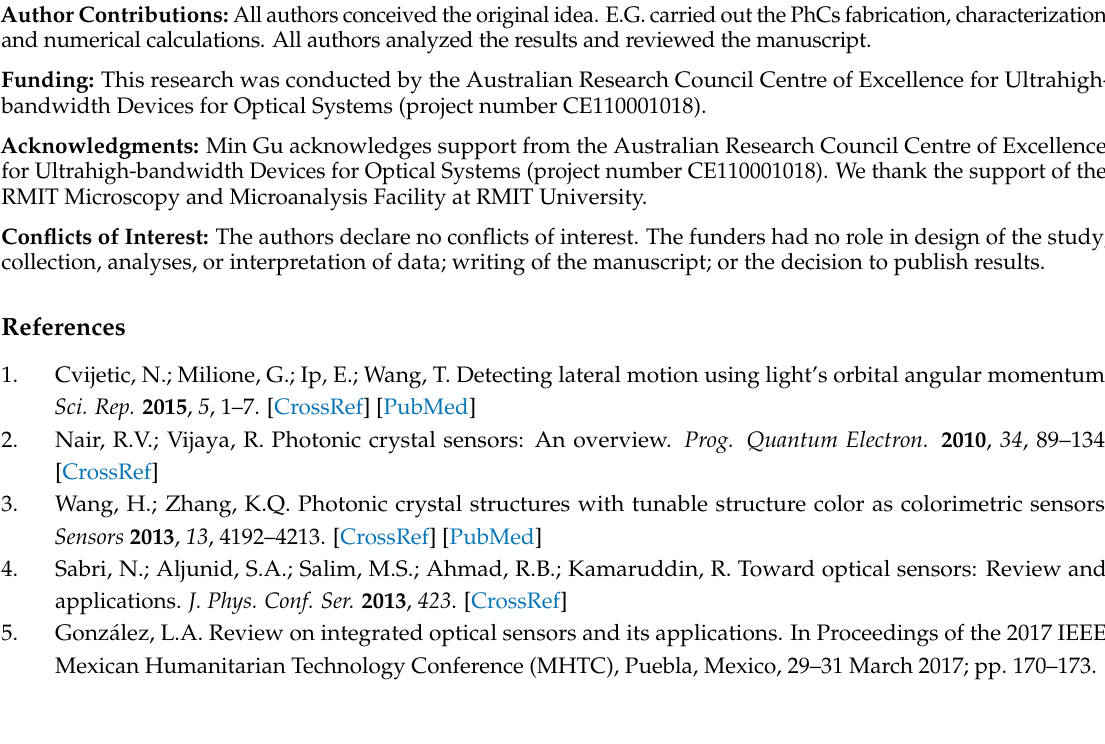
Figure S1: Axial and lateral linewidths obtained from SEM images taken along the [011] direction. (a) In this configuration the sample is tilted by an angle of 45 ◦ , therefore the lateral dimension ∆ X can directly be extracted by the images. To obtain the real ∆ Z value, it is necessary to multiply the measured value by of 2-srs PhC fabricated using DLW and corresponding values of ∆ X, ∆ Z and e . (c) SEM image of 2-srs PhC fabricated using GD-DLW and corresponding values of ∆ X, ∆ Z and e . The software used for the measurements is ImageJ; Figure S2: SEM image of 8-srs PhCs fabricated using GD-DLW demonstrating the beneficial effects of the galvo-dithering on the mechanical stability. The power of the laser (P) is varied from 0.6 mW to 1 mW and the galvo-dithering radius (R) is varied from 0 nm to 900 nm; Figure S3: Experimental transmission spectra for 8-srs PhC fabricated via DLW (R =